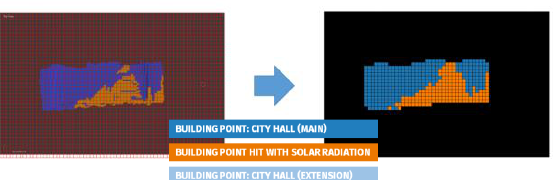
Figure 11. Conversion of the Screenshot of the Model to a Gridded